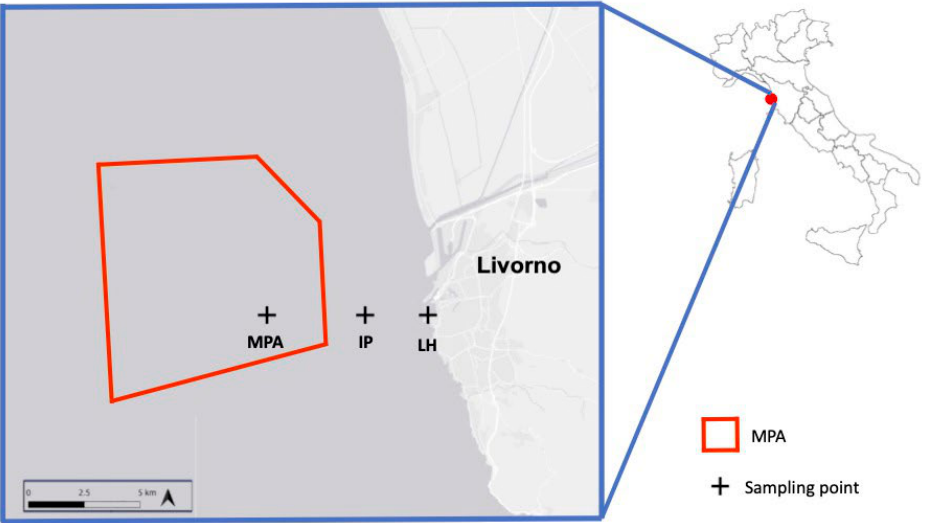
Figure 1. Map of the sampling sites: Livorno Harbor, LH; Intermediate Point, IP; Marine Protected Area “Secche della Meloria”, MPA.